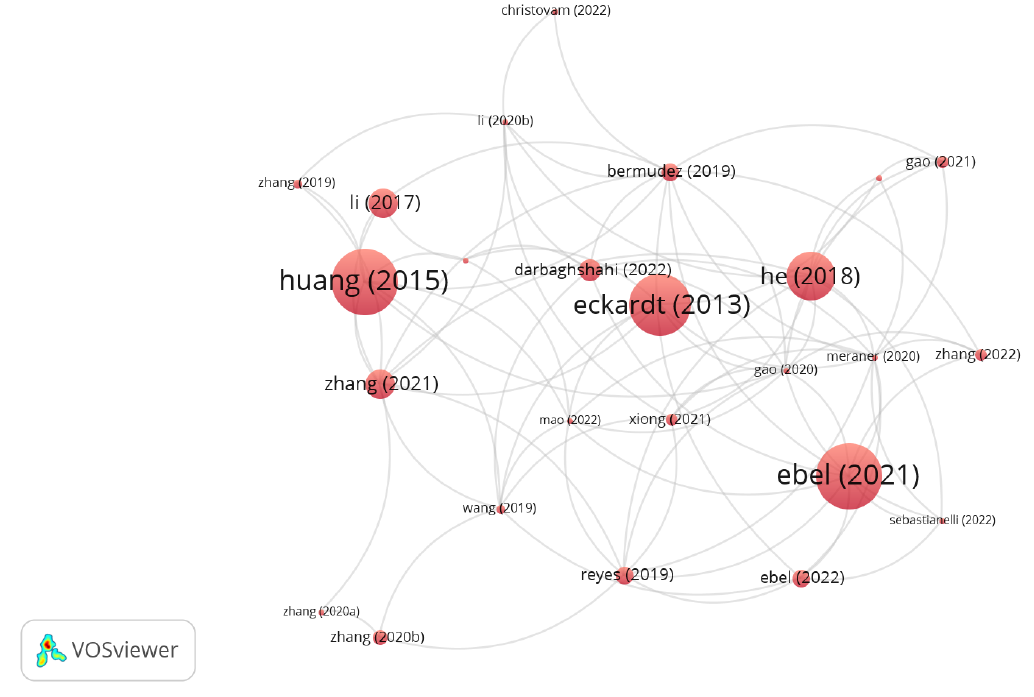
Figure 4. Citation map of the journal literature in Table 1. The size of nodes indicates the count of citations. The citation relationship was derived from Web of